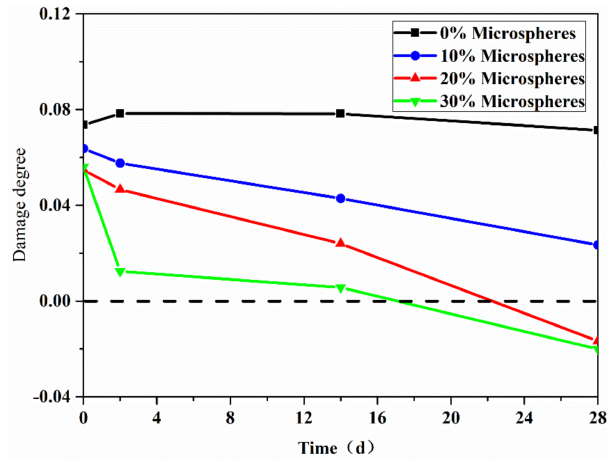
Figure 7. E ff ect of microsphere amount on damage